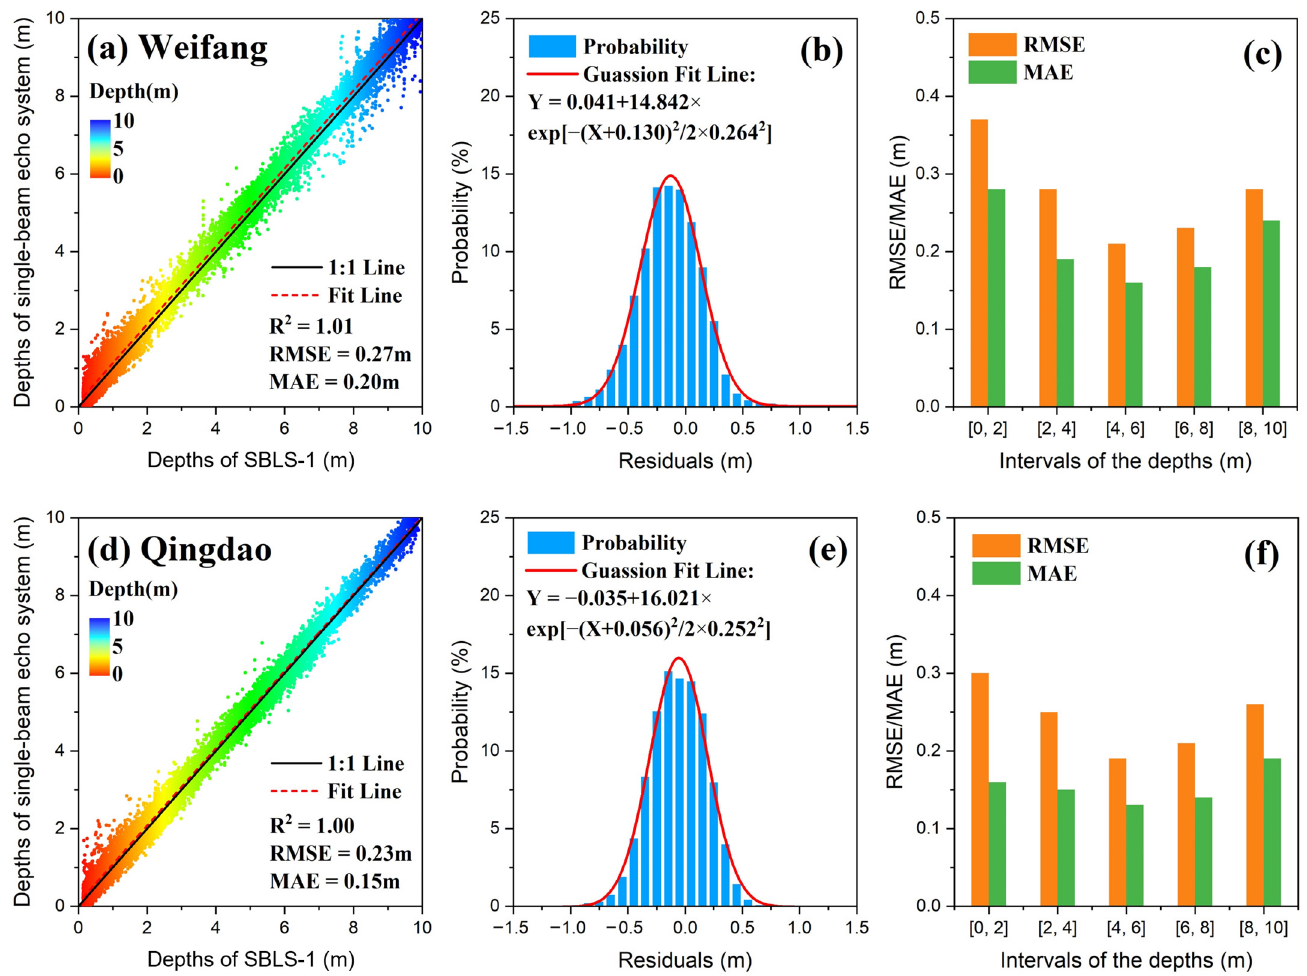
Figure 14. Validation of bathymetric accuracy at the Weifang ( a – c ) and Qingdao ( d – f ) test